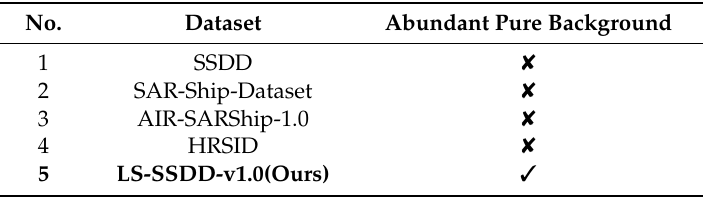
Table 6. Abundant pure backgrounds